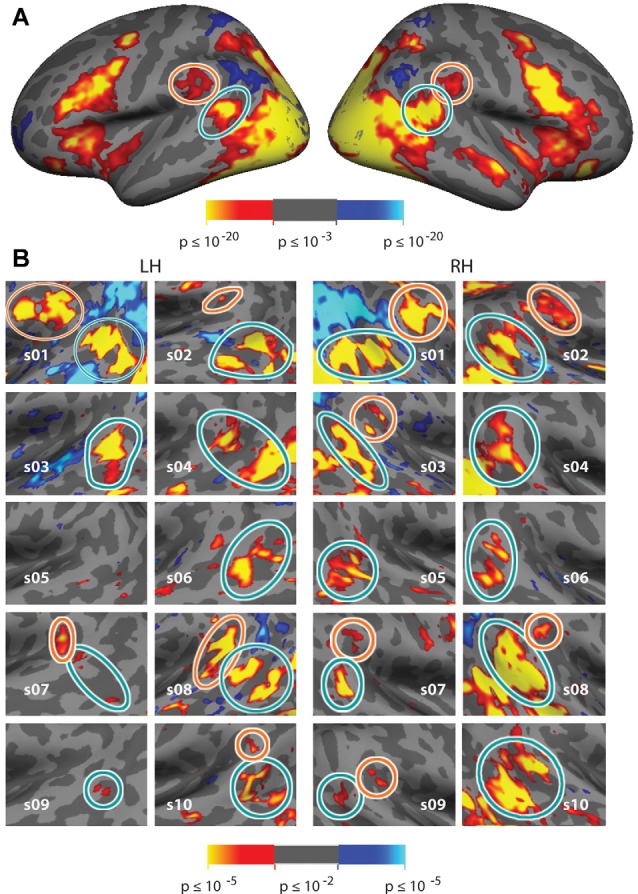
Vivid, Novel Oddball effect in group average and in individual subjects. (A) Group average analysis (N = 10; cluster correction threshold of p < 0.01) of oddball vs. non-oddball trials reveals robust activation in bilateral temporoparietal junction (TPJ) and indicates two distinct patches of activation falling within the region of the TPJ: a large bilateral posterior patch (“TPJSTS,” cyan circle), spanning both banks of the STS, and a smaller bilateral anterior patch (“TPJSMG,” orange circle) in the ventral portion of the Supramarginal Gyrus (SMG). (B) Zoom-in of the same analysis shown in each individual subject (p < 0.01, uncorrected; see also Supplementary Figure S4 for contrast effect sizes).